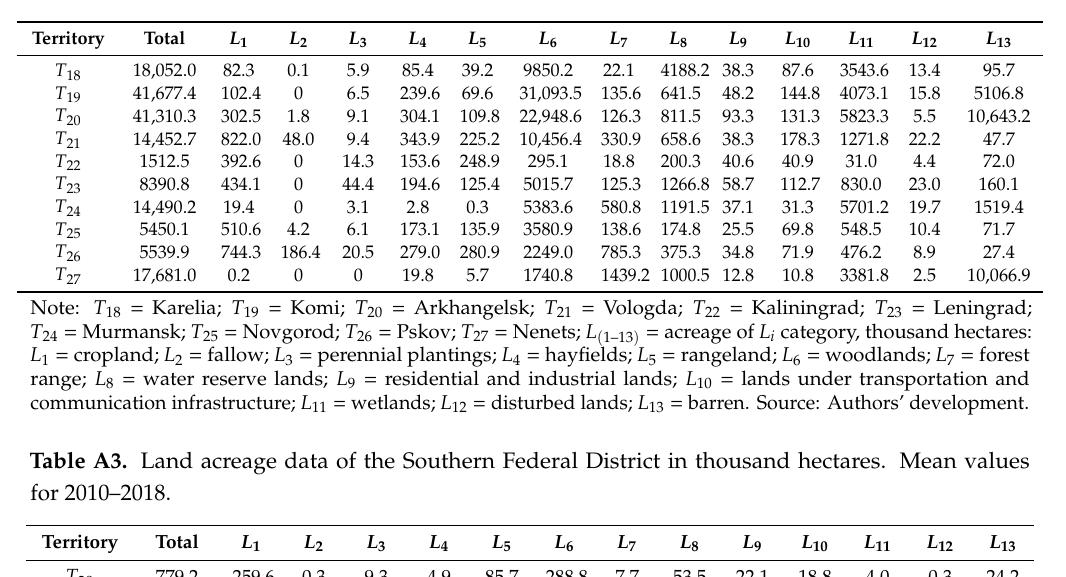
Table A2. Land acreage data of Northwestern Federal District in thousand hectares. Mean values for 2010–2018.